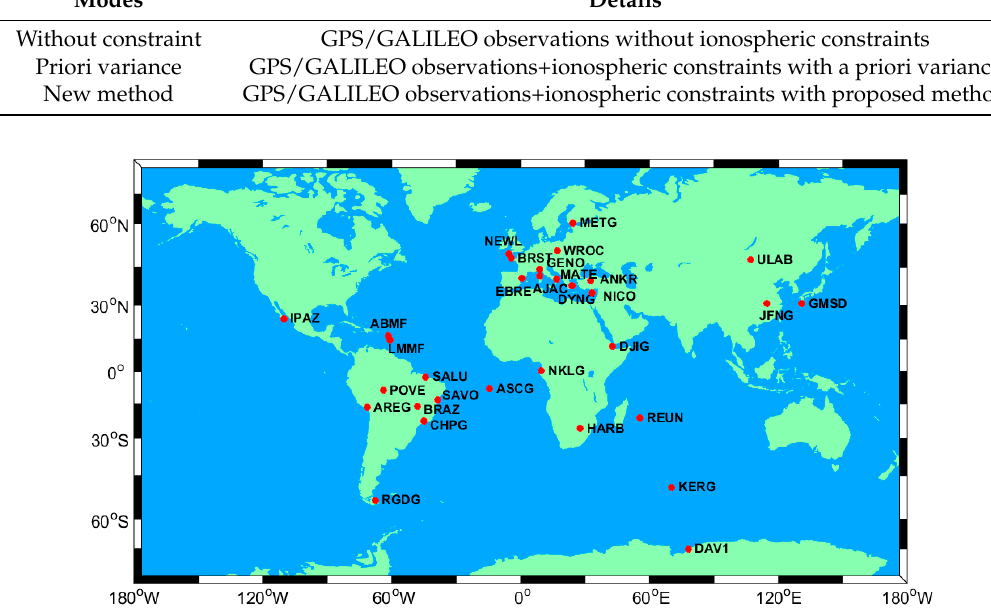
Figure 3. The distribution of MGEX stations in the experiment. Table 2. Strategies for RT GPS/GALILEO PPP.